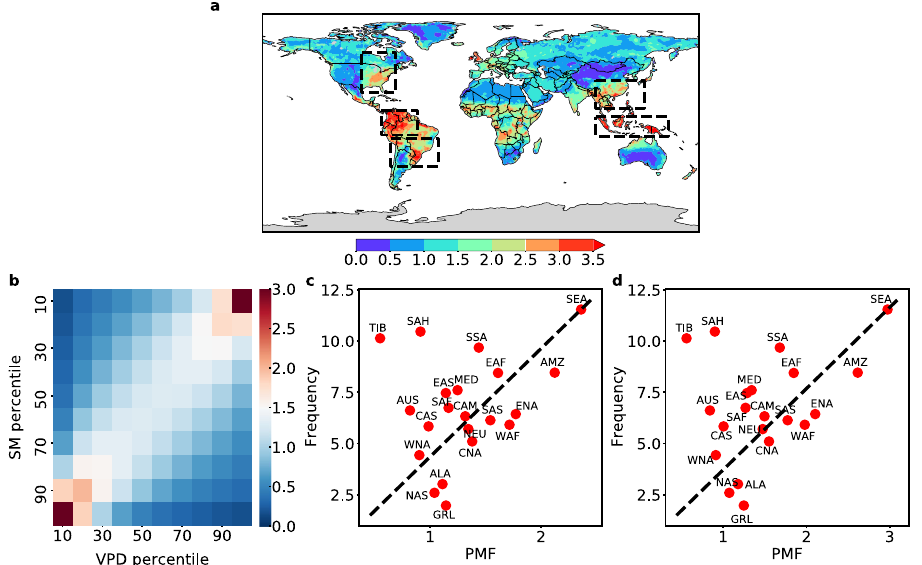
Fig. 4 Relationship between SM and VPD. a Mean PMF of concurrent extreme SM (below the 30th percentile) and VPD (above the 90th percentile) for the period 2000 – 2020 based on three datasets. b Mean probability (%) of percentile bins of SM and VPD across all land grid points. c Spatial relationship between the frequency of occurrence of fl ash droughts and the PMF of SM and VPD extremes (below the 30th percentile SM and above the 90th percentile VPD). d Spatial relationship between the frequency of occurrence of fl ash droughts and the PMF of SM and VPD extremes (below the 20th percentile SM and above the 90th percentile VPD). Each point in c and d is the mean of the results from three